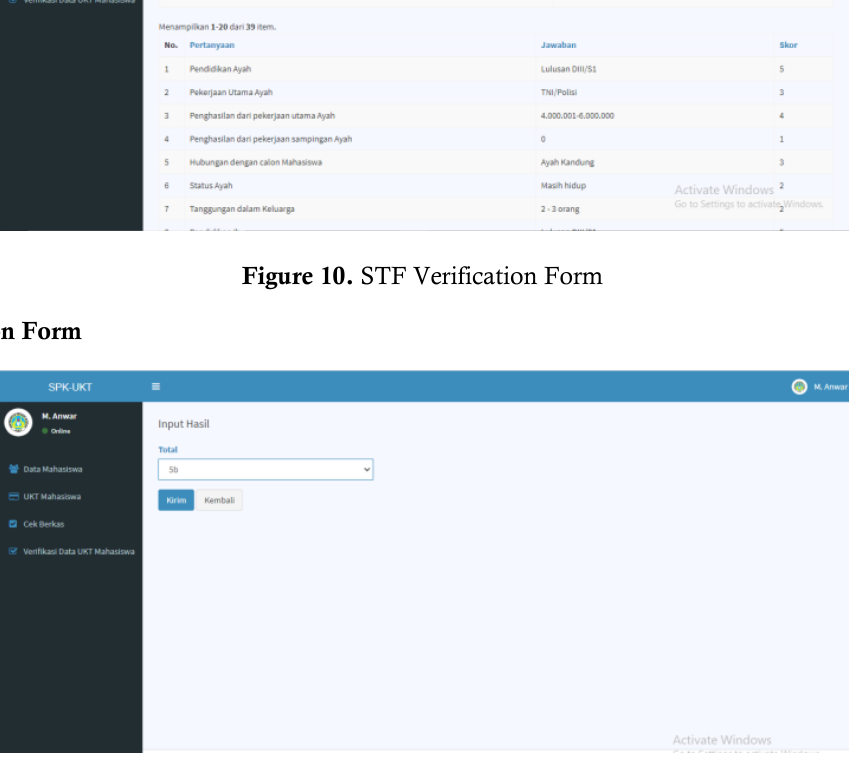
Figure 11. STF Rejection